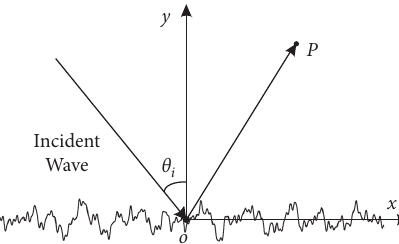
Figure 4: Geometry of near-field scattering from rough surface.